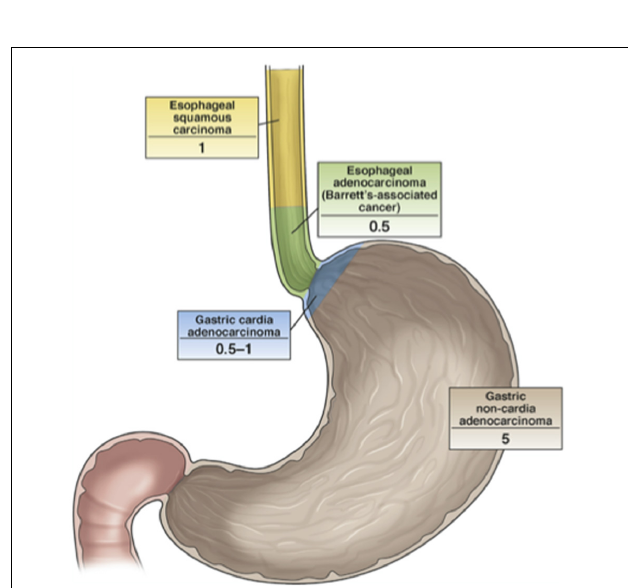
FIGURE 6 | The relationship between H. pylori infection and cancers of the esophagus and stomach. The numbers indicate the odds ratios for the development of the defined cancers in H. pylori -infected vs. uninfected individuals. H. pylori is less common in patients with esophageal adenocarcinoma and gastric cardia adenocarcinoma, even though its protective role for esophageal cancer has not been demonstrated yet (Moss,